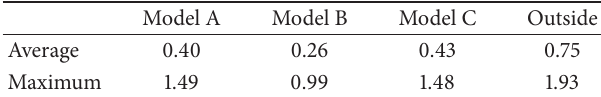
Table 2: Specifications of the windbreaks installed in the weather station (unit = m).